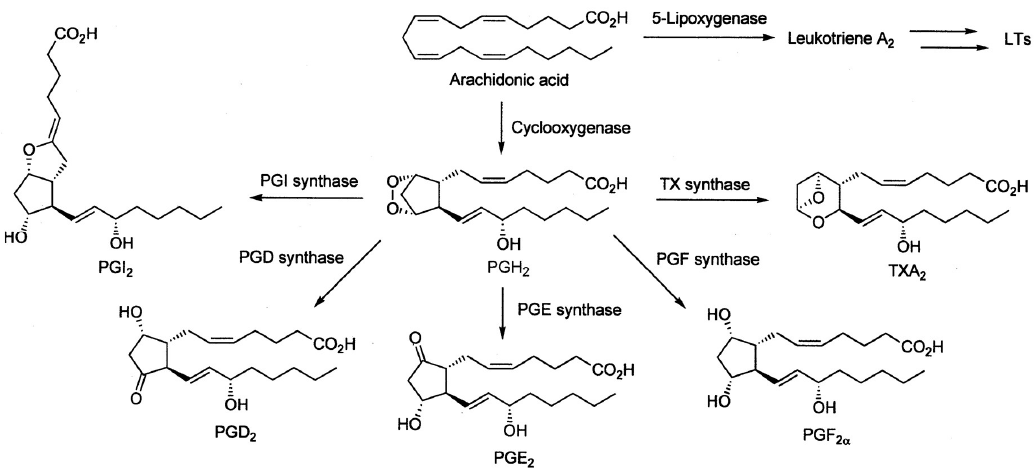
Figure 1. Scheme of prostaglandin and related prostanoid synthesis from arachidonic acid; LTs—